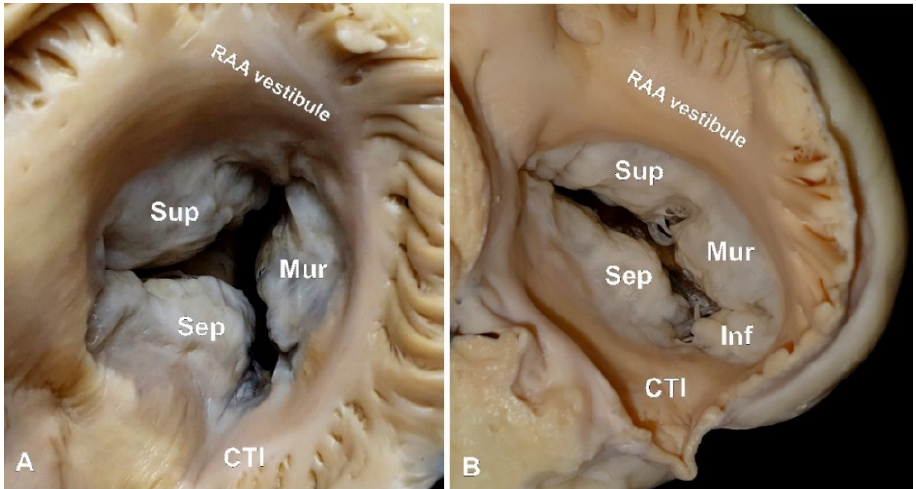
Figure 2. Photographs of a cadaveric heart specimens showing examples of ( A ) 3-leaflet and ( B ) 4-leaflet right atrioventricular valve. CTI—cavo-trisuspid isthmus, RAA—right atrial appendage.